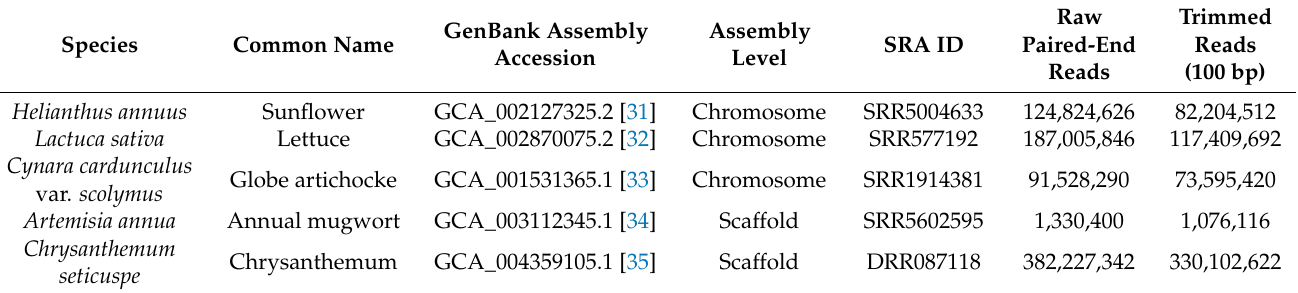
Table 1. Data on Asteraceae genome assemblies and Illumina read packages used.